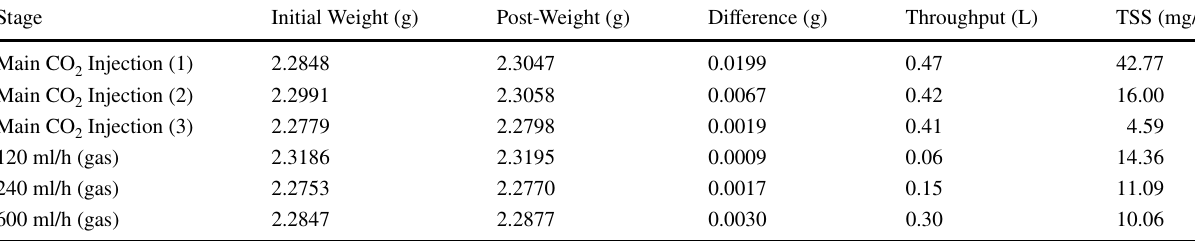
Table 14 Effluent total suspended solids for core flood 5